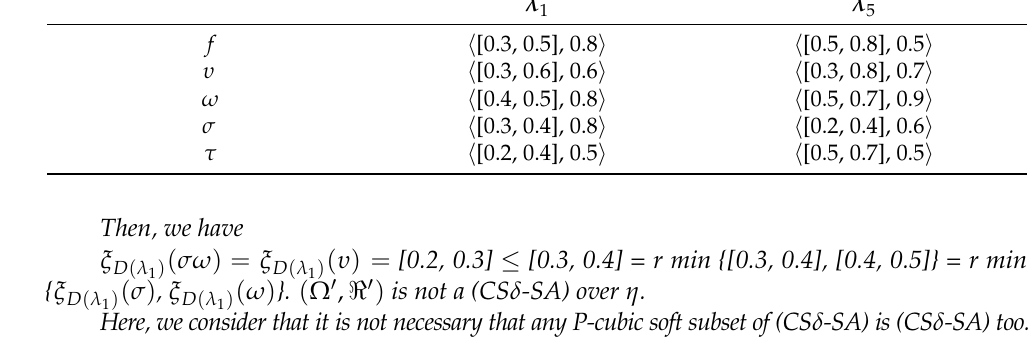
Table 6. ( Ω (cid:48) , (cid:60) (cid:48) ) P-cubic soft subset of ( Ω , (cid:60) ) .